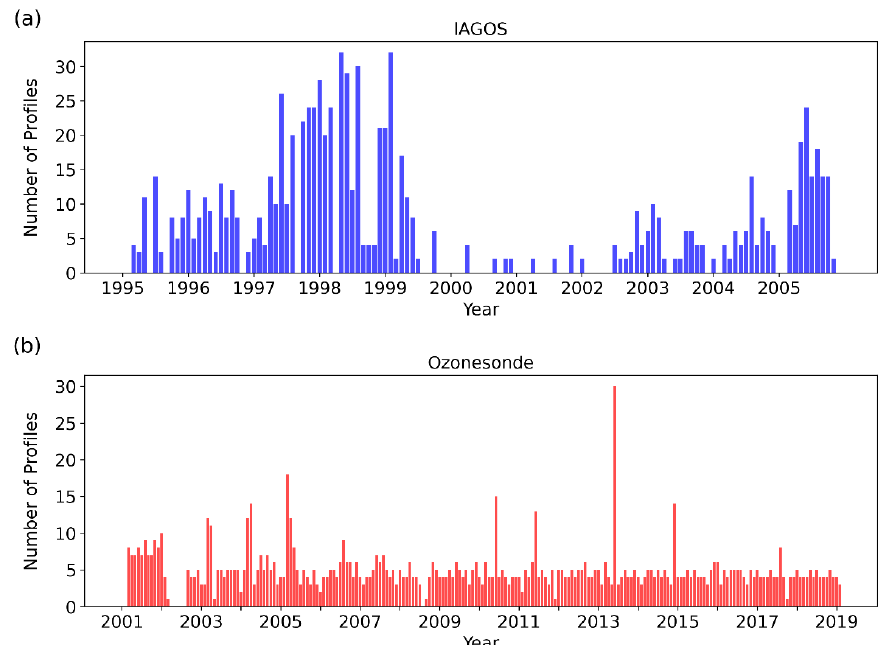
Figure 2. Number of IAGOS profiles ( a ) and the IAP ozonesonde profiles ( b ) over Beijing by month. Twelve stations of hourly ozone measurements in Beijing (their locations shown in Figure 1) after 2014 were also used in this study, which are from the network of sites op- erated by the China Ministry of Ecology and Environment (MEE): https://quotsoft.net/air/,